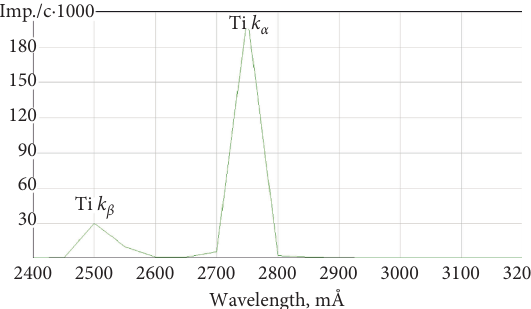
Figure 16: XRF spectrum of titanium atoms, in a composite heat-treated at 300 ° S . Table 3: Parameters of XRF spectra of titanium atoms, in a composite subjected to c